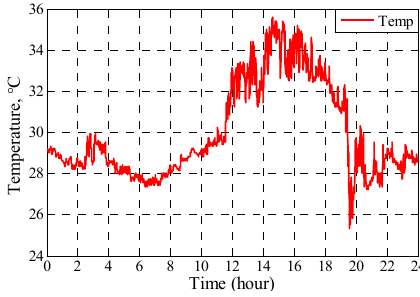
Figure 18. Measured outdoor temperature.